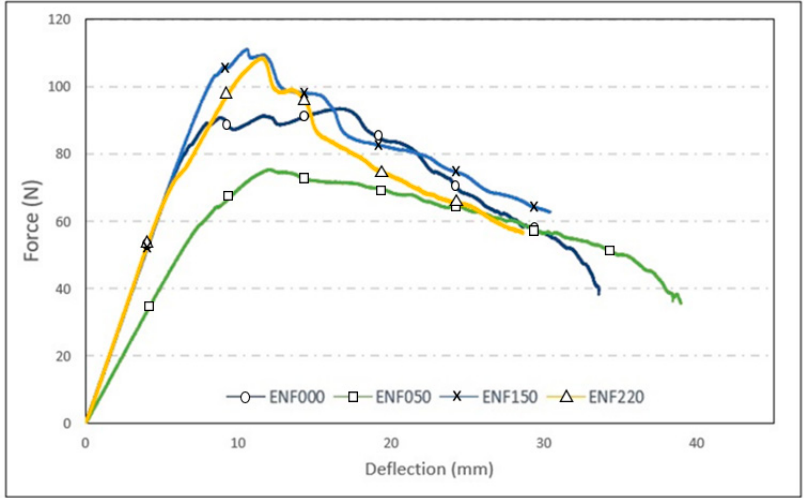
Figure 16. Force-Displacement comparison of different batches of GFRP in Mode II.